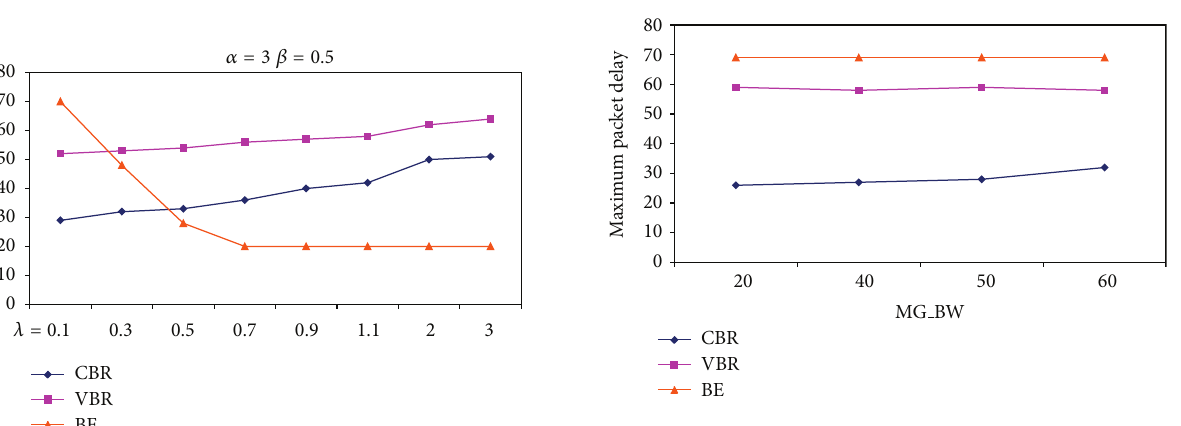
Figure 12: Change in delay due to increase in the amount of minimum guaranteed